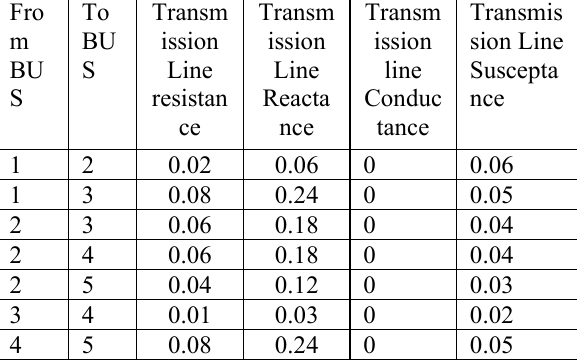
Table 3 Transmission Line Parameter of IEEE 5 BUS